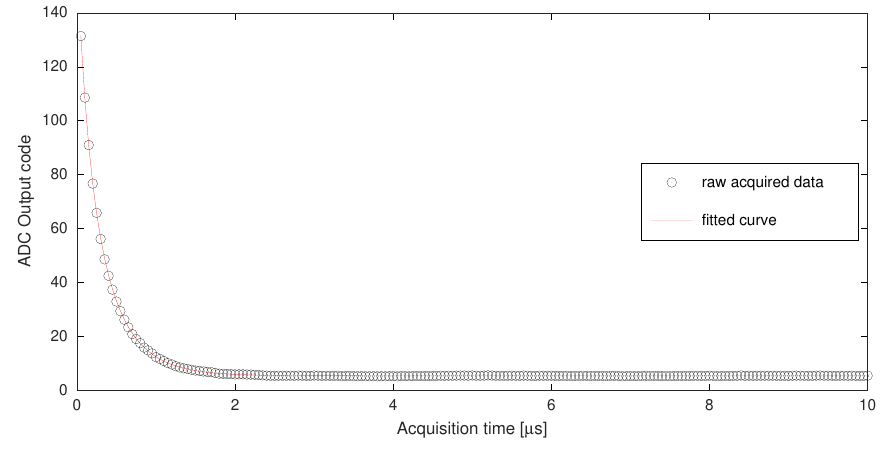
Figure 8. Acquired voltage fitting for zero output